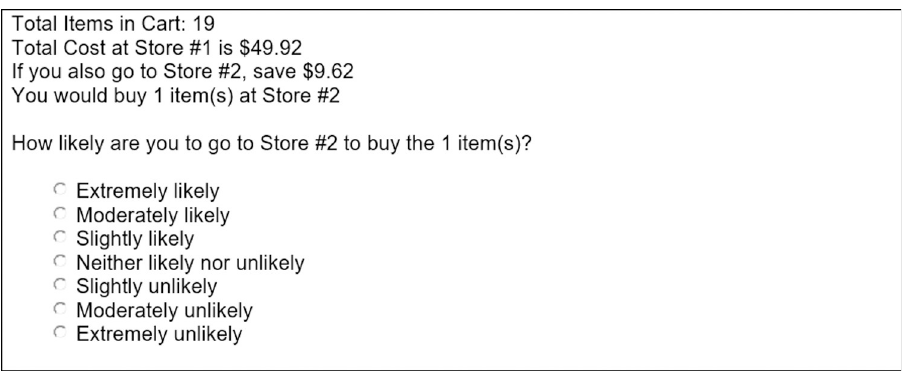
Fig 3. Example study 1